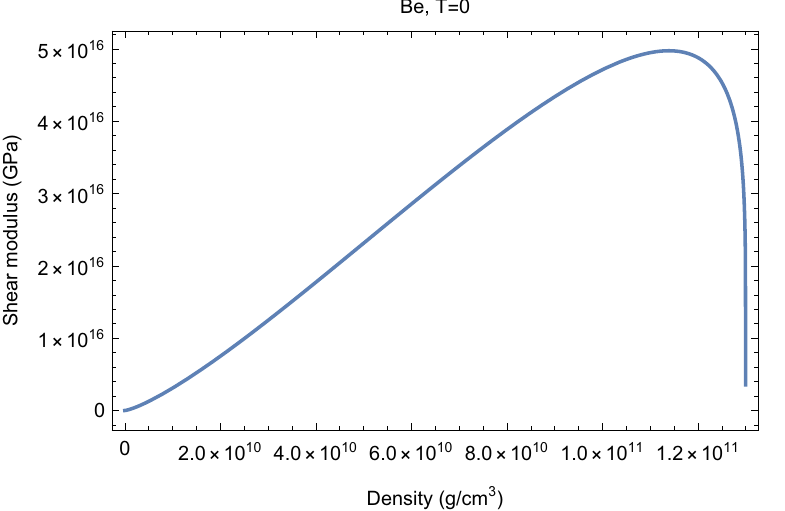
Figure 2. The cold G of Be in the unified analytic melt-shear model with quantum melting included. G terminates at a critical density of 1.3 · 10 11 g/cm 3 .